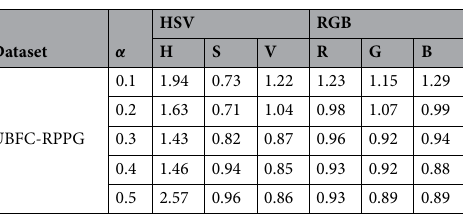
Table 1. AAE values for face skin extraction based on H, S, V, R, G, and B features for different values of the parameter α, using the UBFC-RPPG dataset.